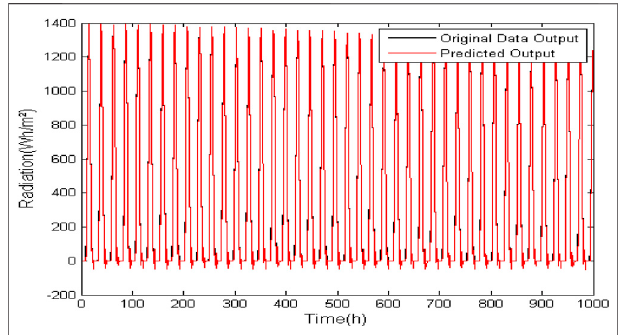
FIGURE 2 | Model ARX (na = 4, nb = 4, nc = 3) for prediction of normal extraterrestrial radiation data without zero suppression.